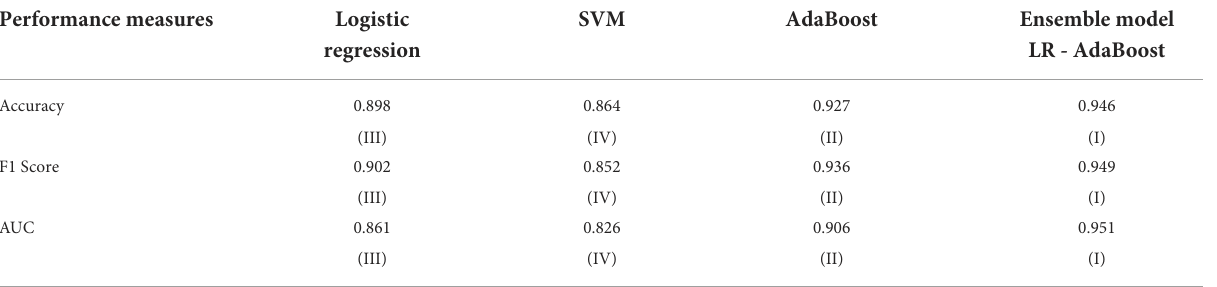
TABLE 2 Comparison of three performance metrics of different models using the PTB-ECG dataset. Performance measures